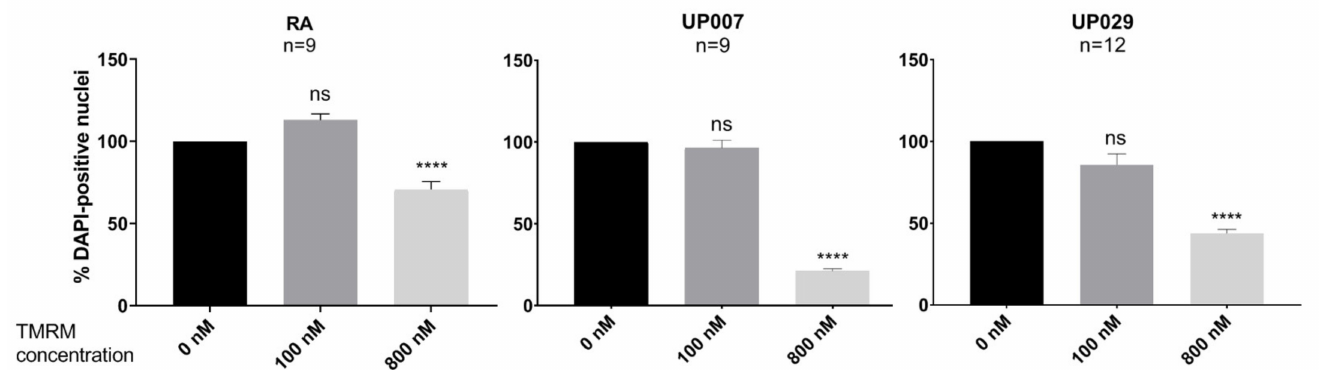
Figure 5. The dependence of TMRM-PDT (0 nM, 100 nM and 800 nM for 30 s; 1.4 mW/mm 2 ) on TMRM concentration. N is the total number of datapoints from 4 independent experiments. (****) p value < 0.001. Differences between the effect of 800 nM on RA (relative decrease in cell density) and either of the GBM cell lines were highly significant ( p < 0.01 in either case). ns—not significant.